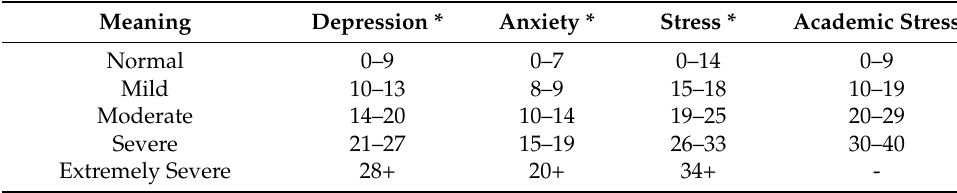
Table A1. DASA scoring rubric for student surveys.